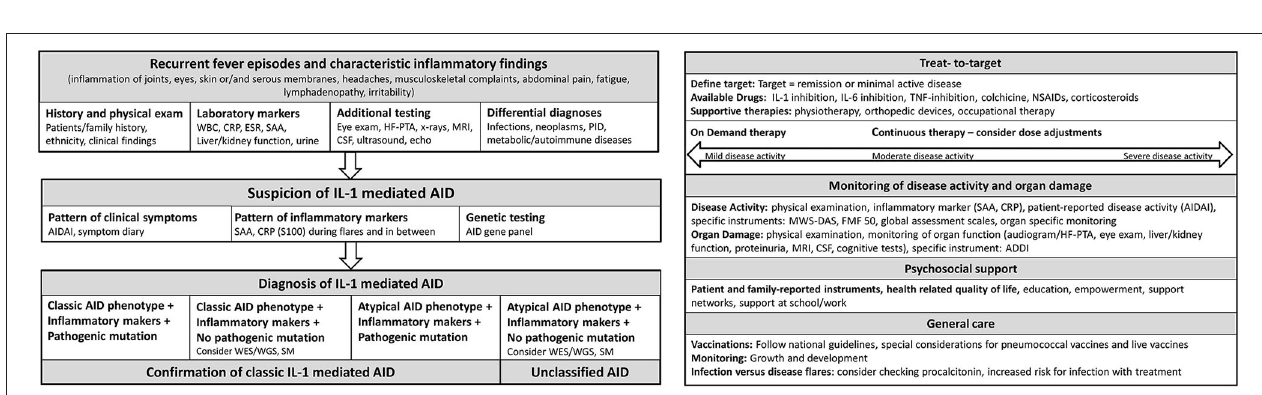
FIGURE 2 | Flow sheet diagnostic steps and management of AID. AID, autoinflammatory disease; WBC, whole blood count; CRP, c reactive protein; ESR, erythrocyte sedimentation rate; SAA, Serum Amyloid A; HF-PTA, high frequency pure tone audiogram; MRI, magnet resonance imaging; CSF, cerebrospinal fluid; PID, primary immune deficiency; IL, Interleukin; AIDAI, Autoinflammatory Disease Activity Index; S100, S 100 proteins; WES, whole exome sequencing; WGS, whole genome sequencing; SM, somatic mosaicism; TNF, Tumor necrosis factor; NSAIDs, Nonsteroidal anti-inflammatory drugs; MWS-DAS, Muckle Wells Syndrome Disease activity score; FMF 50, Familial Mediterranean Fever 50 Score; ADDI, Autoinflammatory Disease Damage